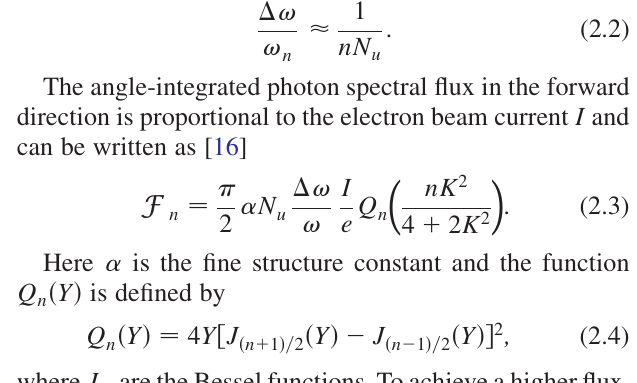
ð nK 2 Þ . n 4 þ 2 K 2